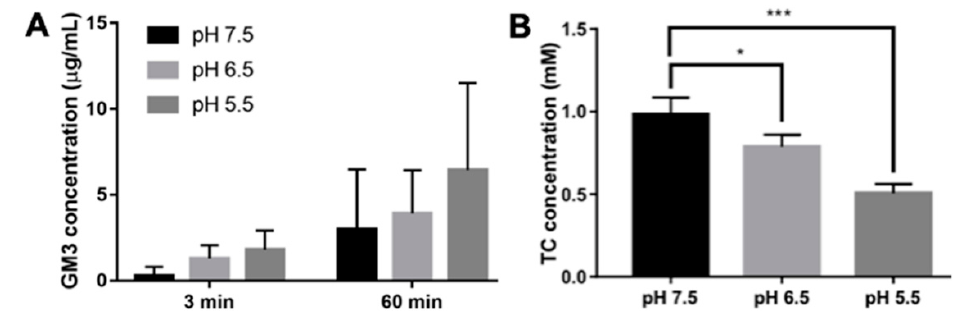
Figure 9. Solution acidification enhances the release of GM3 and cholesterol in GM3-rHDL particles. ( A ) The concentration of the released GM3 from GM3-rHDL particles at different pH values for 0 and 1 h ( n = 3). ( B ) The concentration of total cholesterol (TC) remaining in GM3-rHDL particles at different pH values for 1 h. * p < 0.05 and *** p < 0.001 ( n = 4).